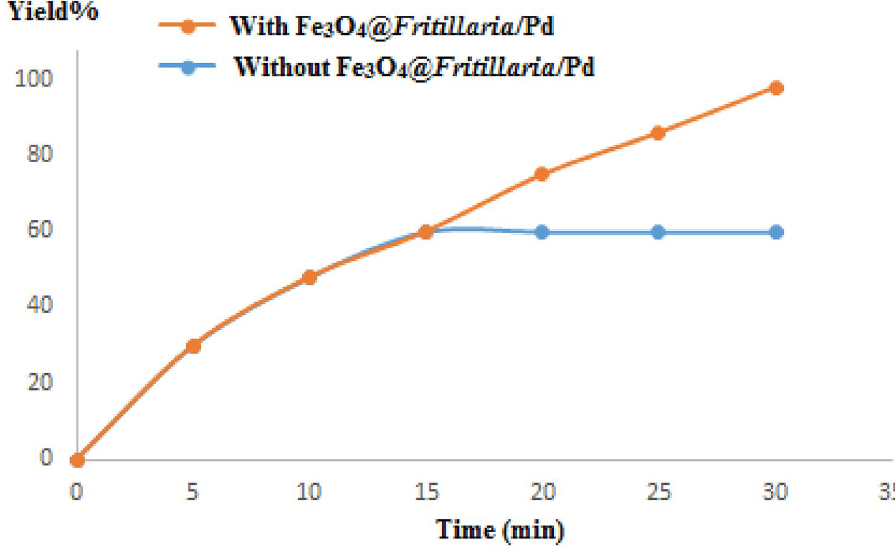
Figure 11. Hot filtration and leaching test of Fe 3 O 4 @ Fritillaria /Pd in the reduction of